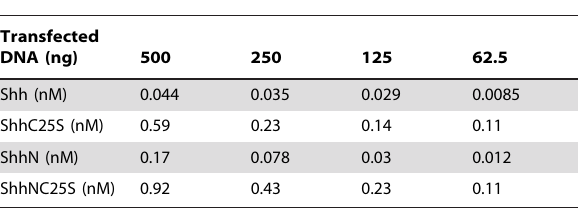
cell staining for Shh within viable EGFP-positive cells (filled histogram) relative to control cells (unfilled histogram). Figure S4 Two distinct species of recombinant protein in ShhN conditioned medium. (A–B) ShhNC25S and ShhN